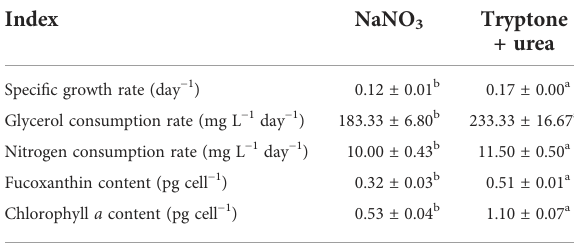
TABLE 1 The speci fi c growth rate, carbon and nitrogen consumption rate, and pigment content in the mixotrophic growth of P. tricornutum using NaNO 3 and the mixture of tryptone and urea (1:1, mol N:mol N) as nitrogen source at 20 mmol N L − 1 in shaking fl